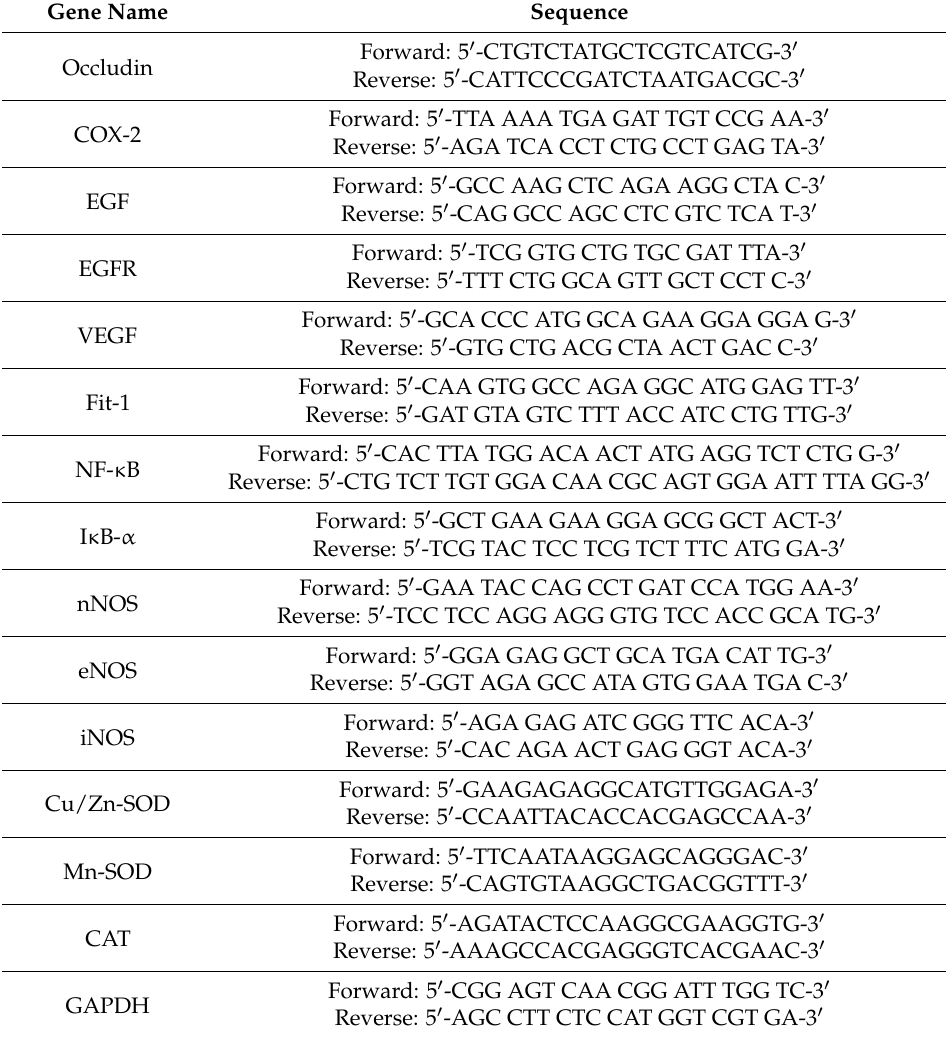
Table 1. Sequences of reverse transcription-polymerase chain reaction primers used in this